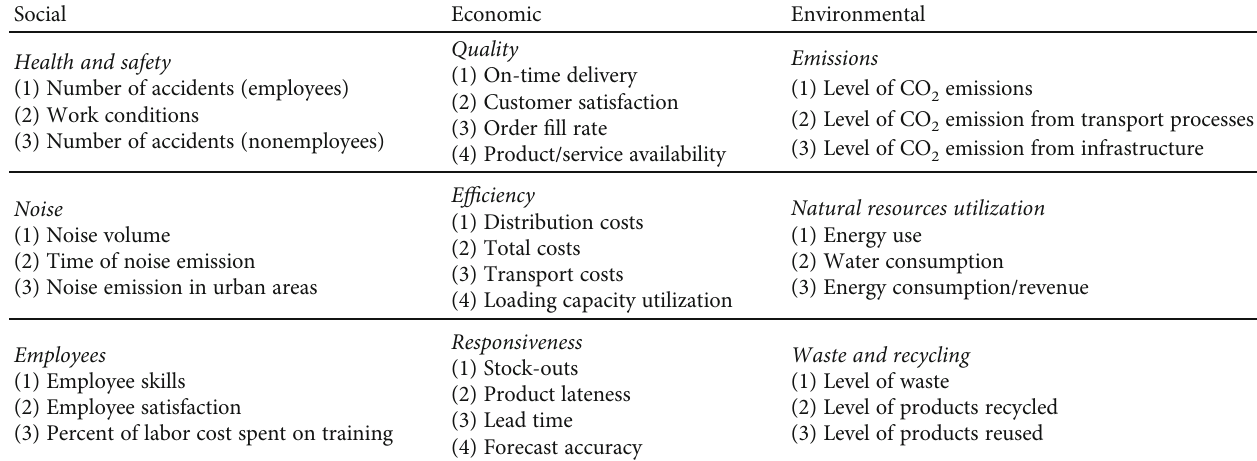
Table 2: Supply chain metrics: performance indicators on sustainability